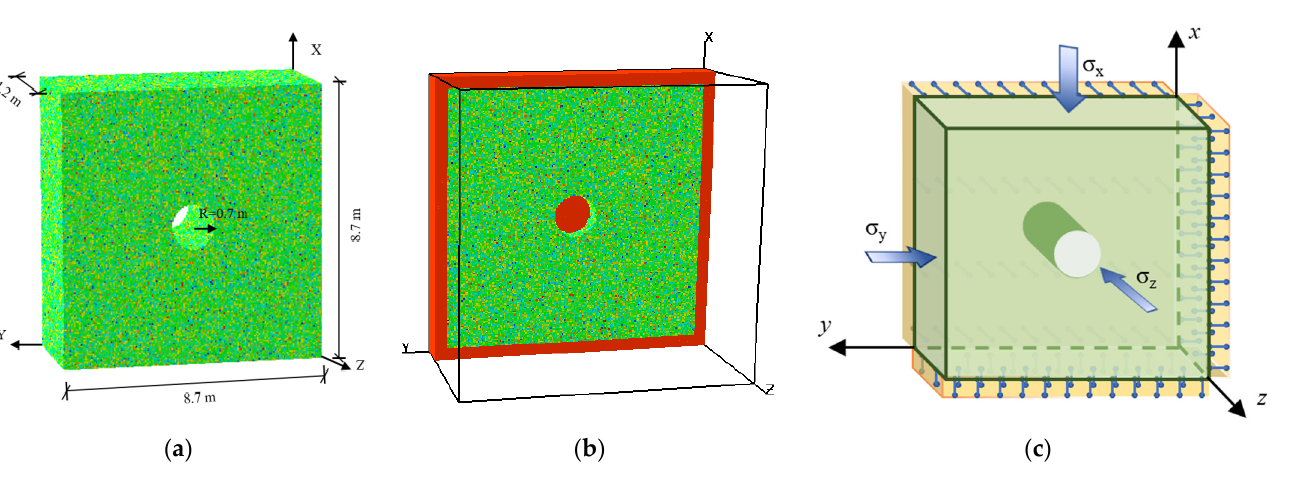
Figure 3. Heterogeneous numerical model containing circular tunnel without joints: ( a ) Model size; ( b ) layout of backing plates; ( c ) loading conditions. Table 1. Physical and mechanical parameters of model material. Parameter